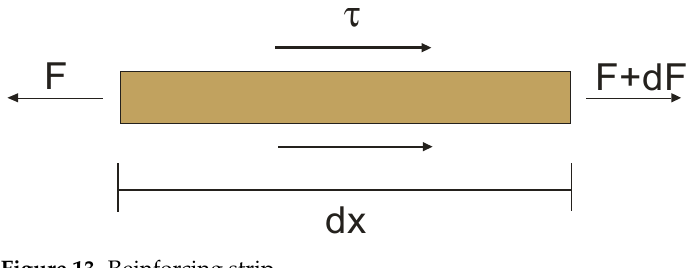
Figure 13. Reinforcing strip.